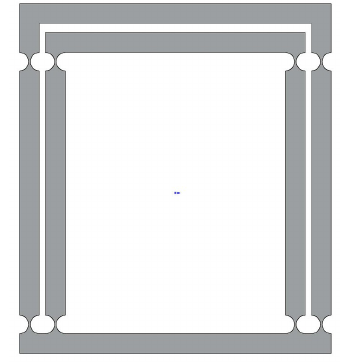
Figure 6. The decoupled flexure